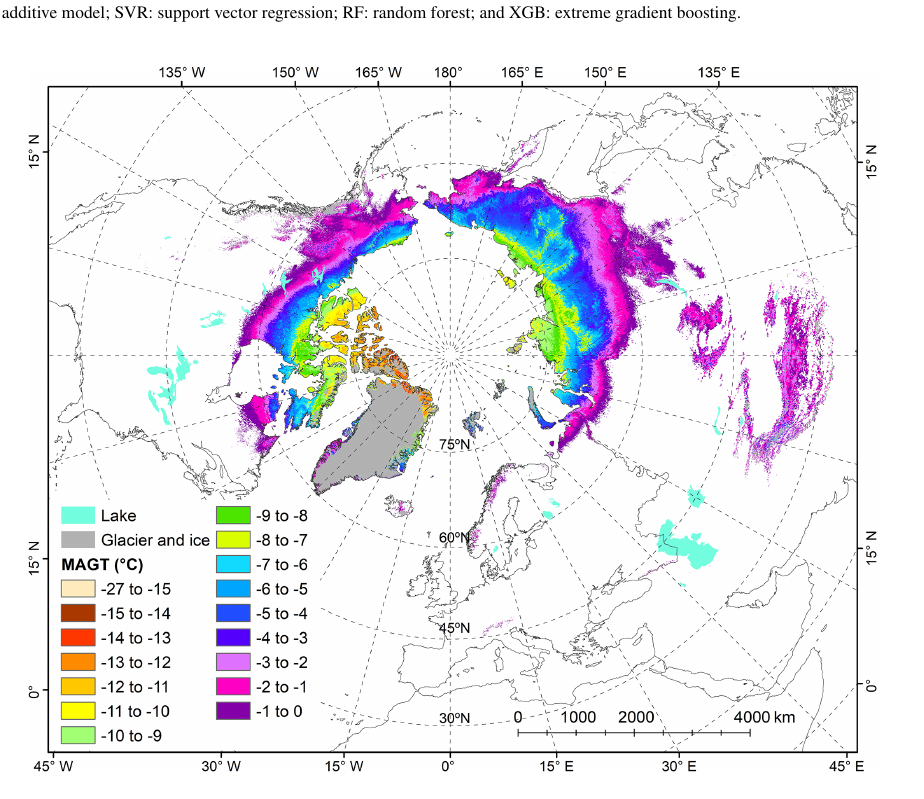
Figure 3. Distribution of the mean annual ground temperature (MAGT) at the zero annual amplitude depth (approximately 3 to 25m) average in the Northern Hemisphere for the period of